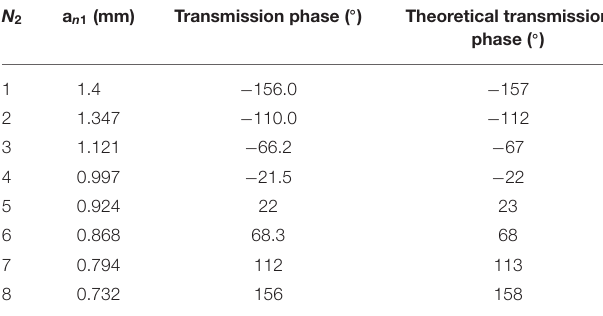
TABLE 2 | Deflection 31.88 ◦ array unit